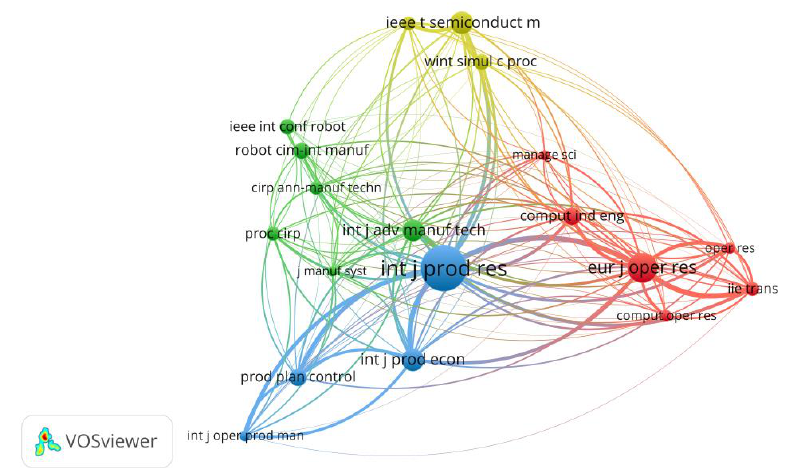
Figure 1. Co-citation map of WoS search results .